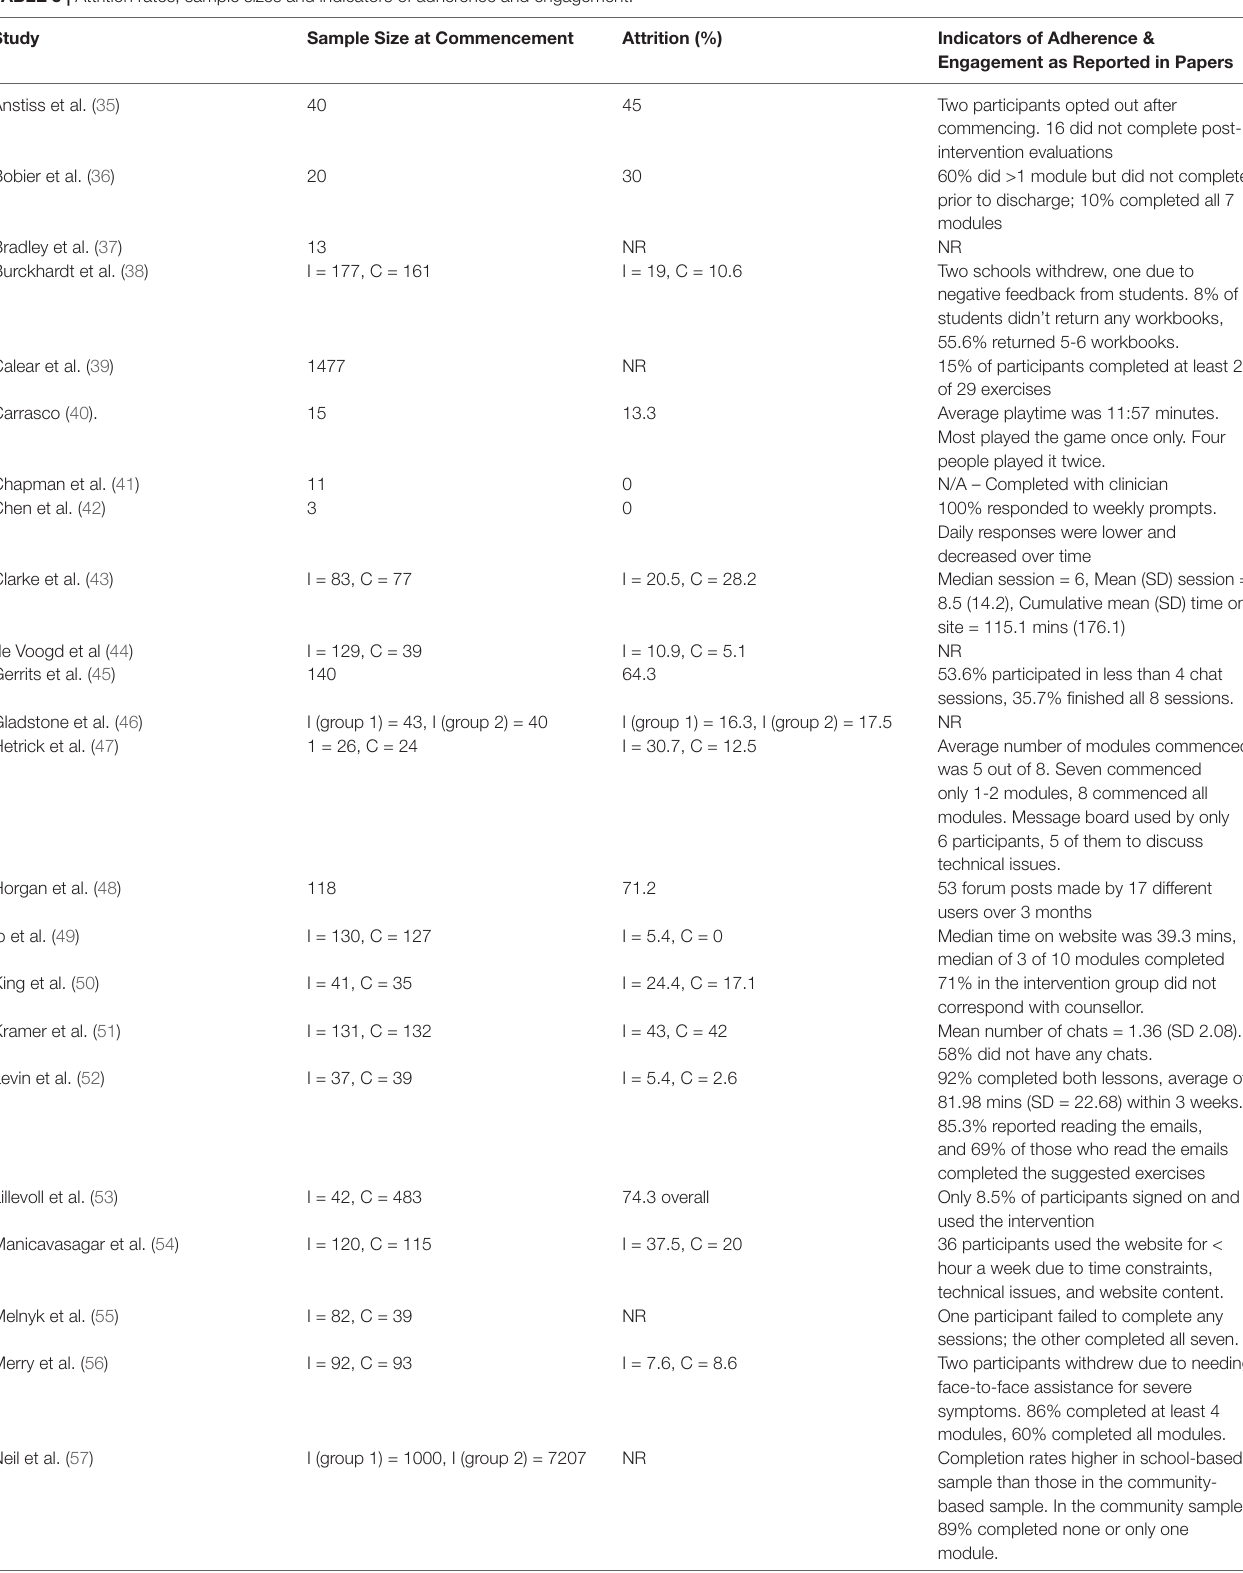
TABLE 5 | Attrition rates, sample sizes and indicators of adherence and